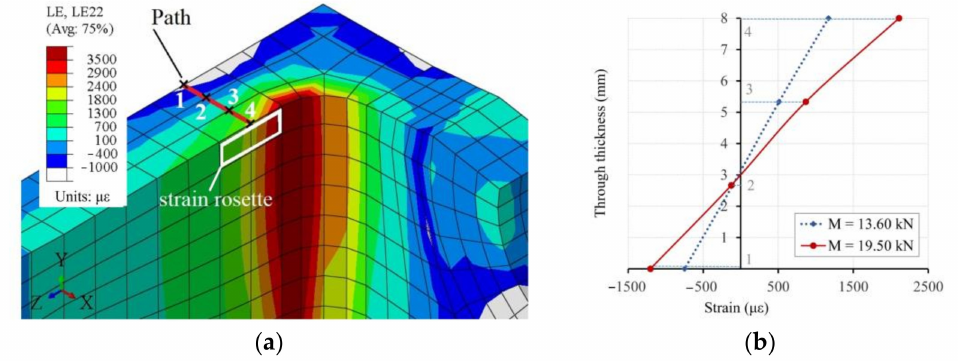
Figure 14. ( a ) Cut view of angle cross-section to define through-thickness path (points 1, 2, 3 and 4); ( b ) transversal logarithmic strain (LE22) through the thickness of the connecting angle at strain rosette location.